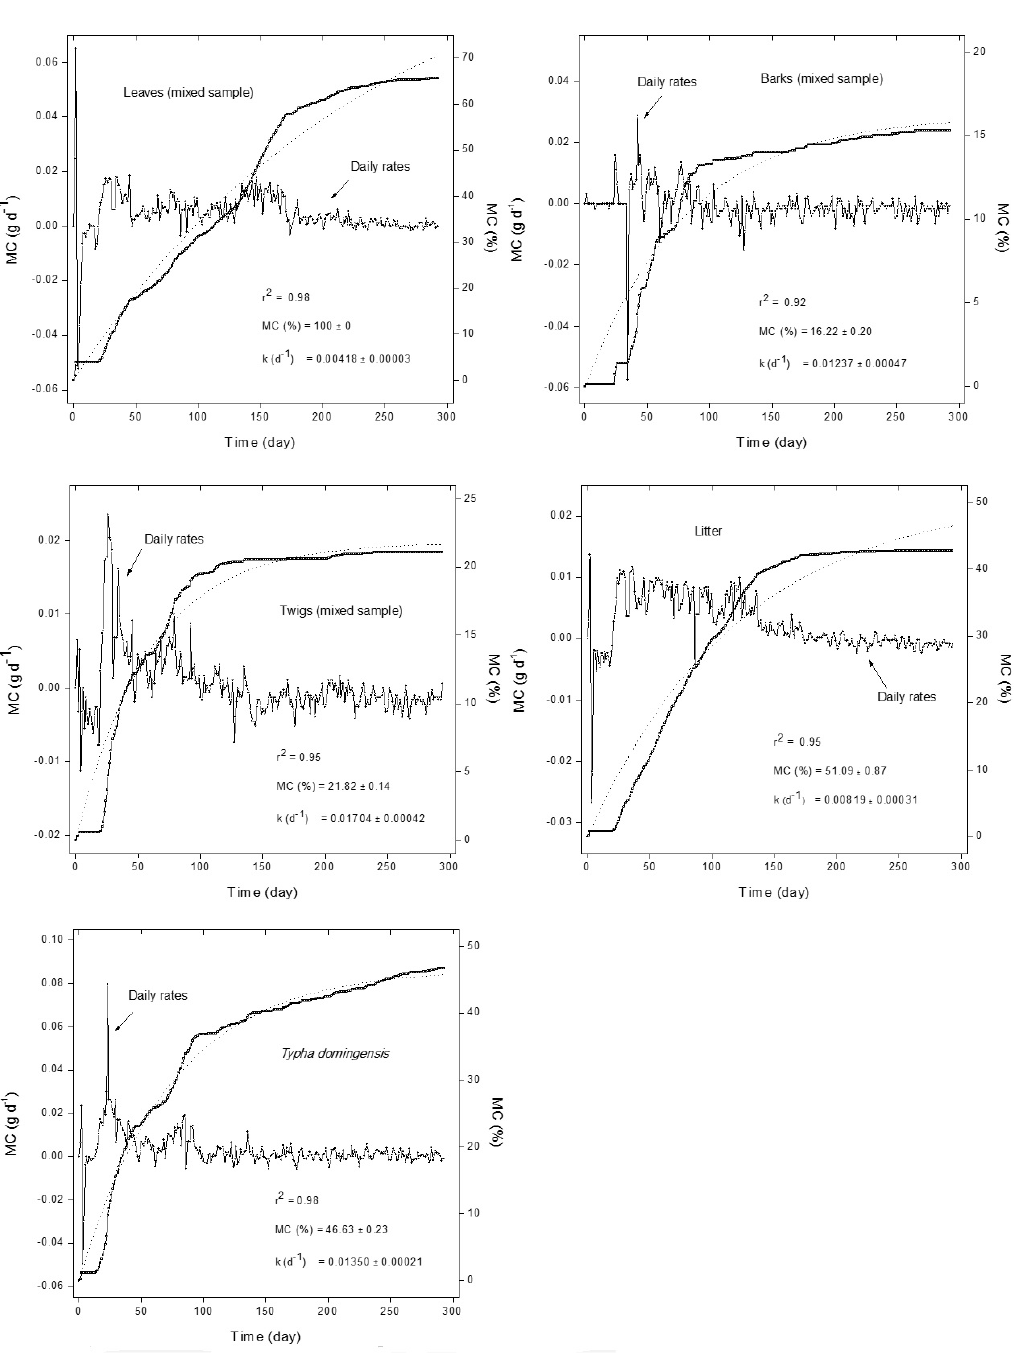
Figure 2. Mineralization daily rates, accumulated MC (points: experimental results; dotted lines: model results) during anaerobic decomposition, under aquatic media of mixed samples of leaves, twigs, bark and Typha domingensis . The kinetic parameters (MC and k) and the determination coefficient (r 2 ) from the kinetic fittings are also